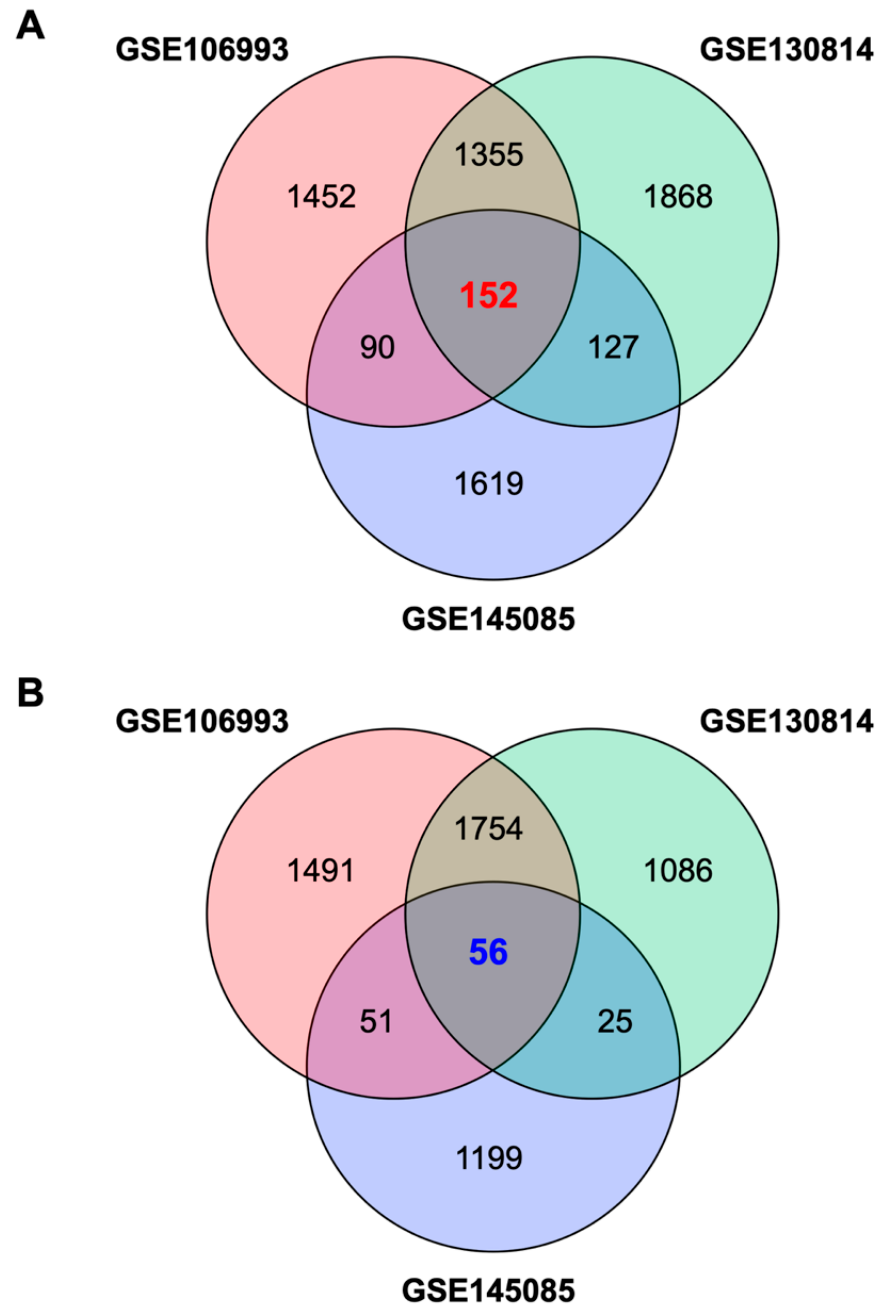
Figure 1. Venn diagrams of genes contained in the gene expression signature associated with cisplatin-induced nephrotoxicity (GES-CIN). Venn diagrams of unique and shared differentially expressed genes in untreated vs. cisplatin-treated mouse kidneys (GSE106993 and GSE130814) or human kidney organoids (GSE145085). Differentially expressed genes were identified using a false discovery rate threshold of 1% (Table S1). ( A , B ) show genes upregulated and downregulated by cisplatin treatment, respectively.